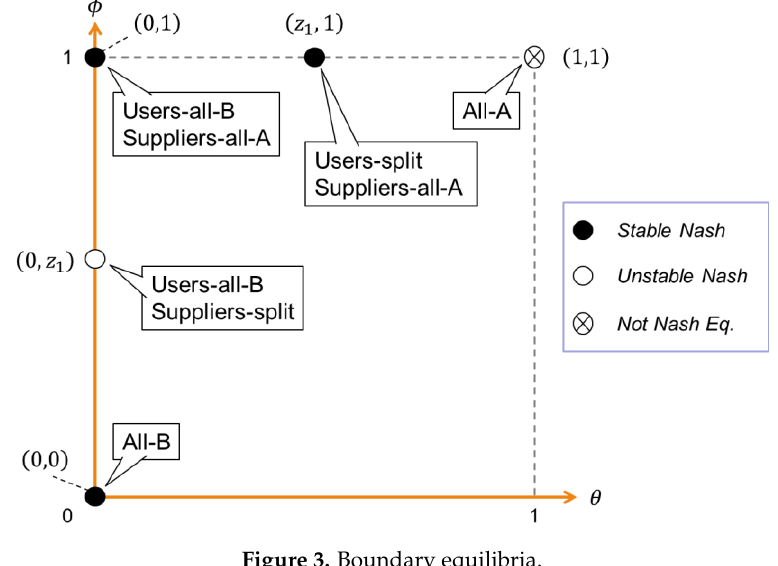
Figure 3. Boundary Figure 3. Boundary equilibria.